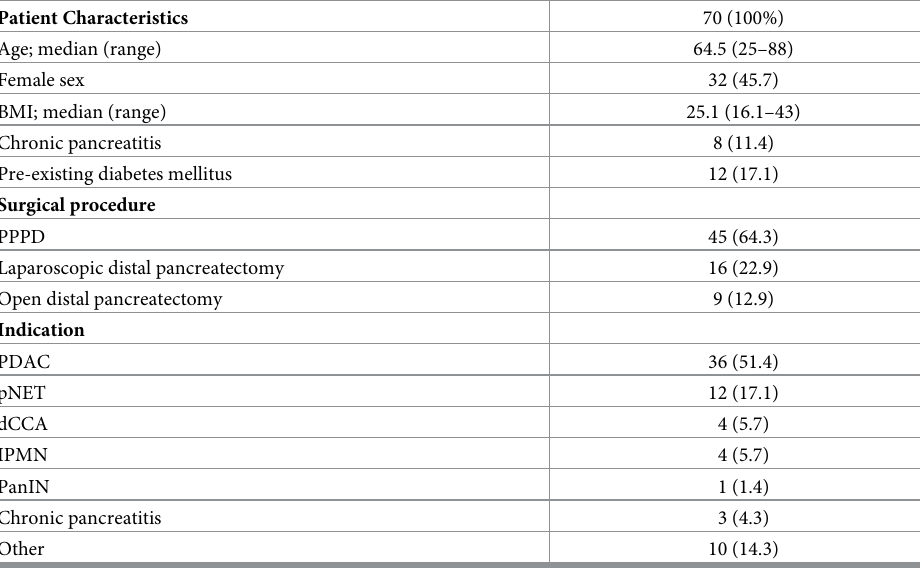
Table 1. Patient characteristics and surgical details (n = 70). Patient